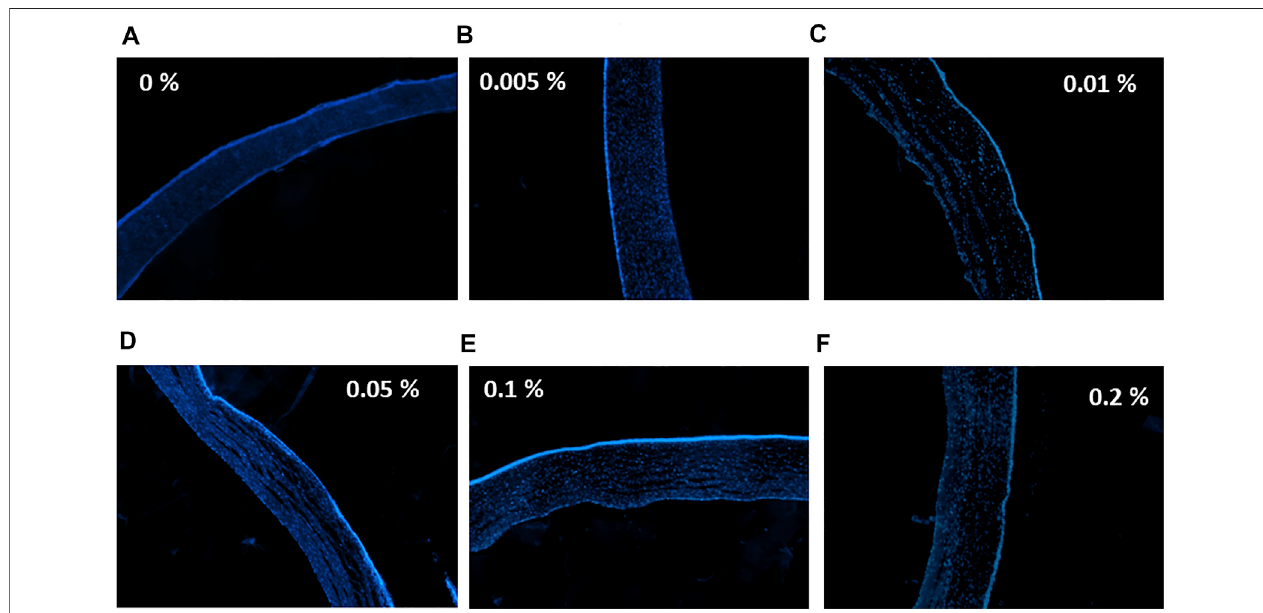
FIGURE 4 | The effect of tacrolimus on stromal and epithelial cell densities. Concentrations of tacrolimus solutions used to treat each group of corneas are shown ontheleft.DAPIstainingisshowninblue. (A) ControlcorneastreatedwithPBS, (B) corneastreatedwith0.005%tacrolimus, (C) corneastreatedwith0.01%tacrolimus, (D) corneas treated with 0.05% tacrolimus, (E) corneas treated with 0.1% tacrolimus, (F) corneas treated with 0.2% tacrolimus. Each image is a representative of three replicates ( n = 3). All images were captured using ×10 magni fi cation using a laser scanning confocal